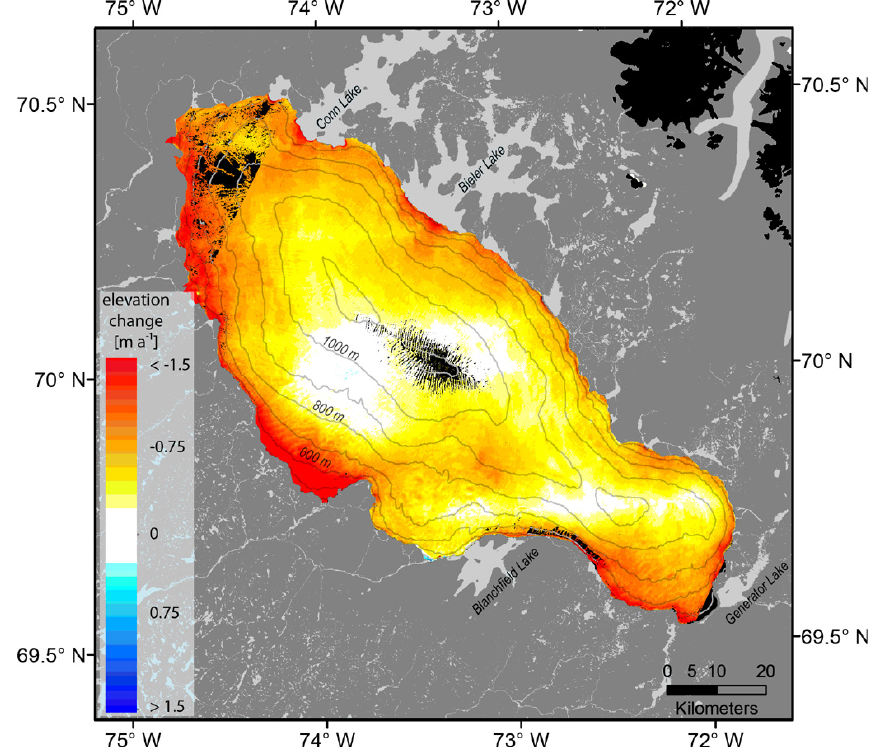
Fig. 3. Elevation change (ma − 1 ) of the Barnes Ice Cap between 1960 and 2010 as determined from DEMs generated from airborne and SPOT-5 satellite stereoscopic imagery. Areas of black indicate no